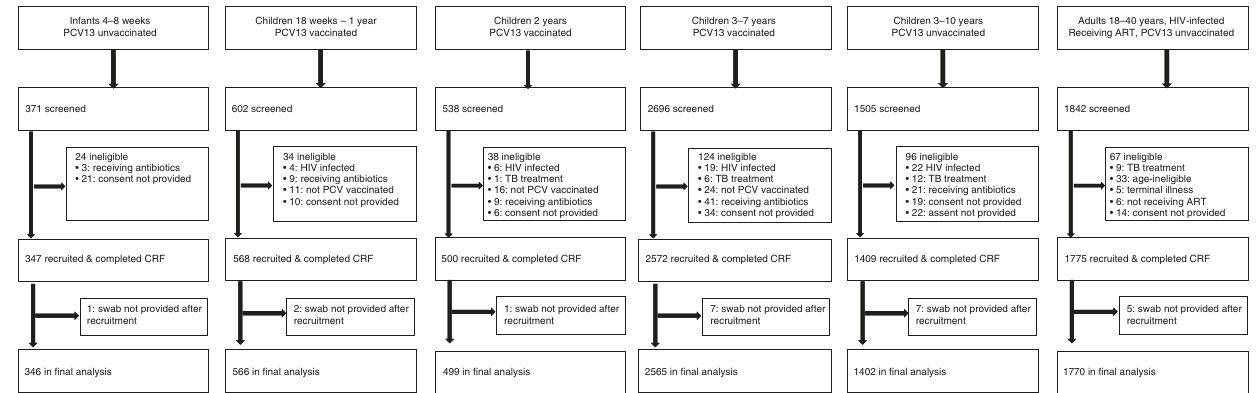
Fig. 1 Recruitment fl ow diagram. Among school-goers (6 – 10 years old), the number reported as screened does not include parents/guardians who did not come to the school after written invitation. Overall, 3781 letters of invitation were sent to parents/guardians during recruitment of school-goers. Of these, 1493 (39.5%) came to the school to be further informed of the study and consider their child ’ s participation. Reasons for not accepting the invitation were not routinely collected. A total 1427 school-goers were recruited. Among children recruited from household (18 weeks to 5 years old), study teams maintained a diary of number of homes visited (i.e. knocked on gate/door of main house). An average of 7.2 household were approached for every child screened. Reasons for failing to screen-at-household included, (i) no one home, (ii) someone home but no age-eligible child home, and (iii) age-eligible child home but no parent/guardian